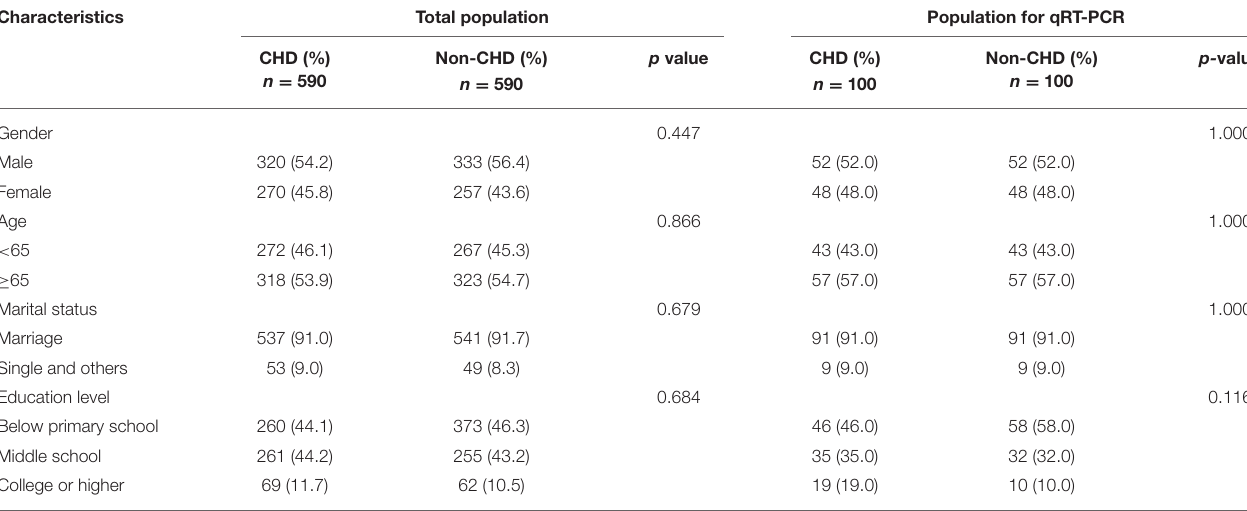
TABLE 1 | Baseline characteristics of study participants.